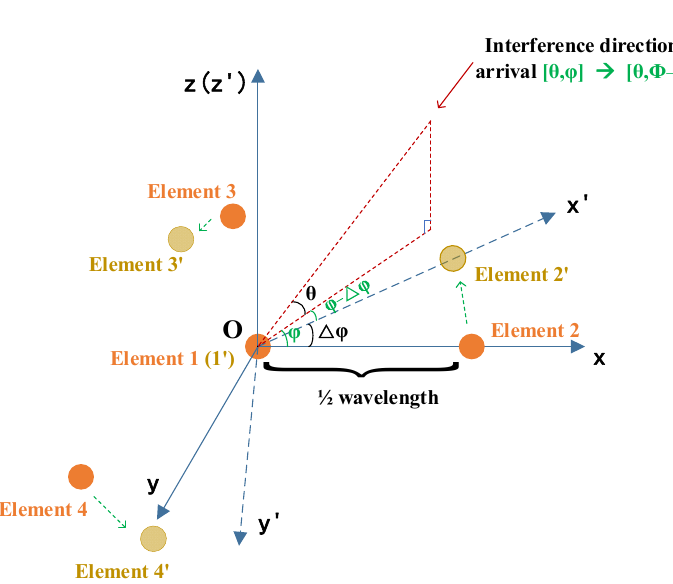
Figure 2. Antenna array rotation diagram.